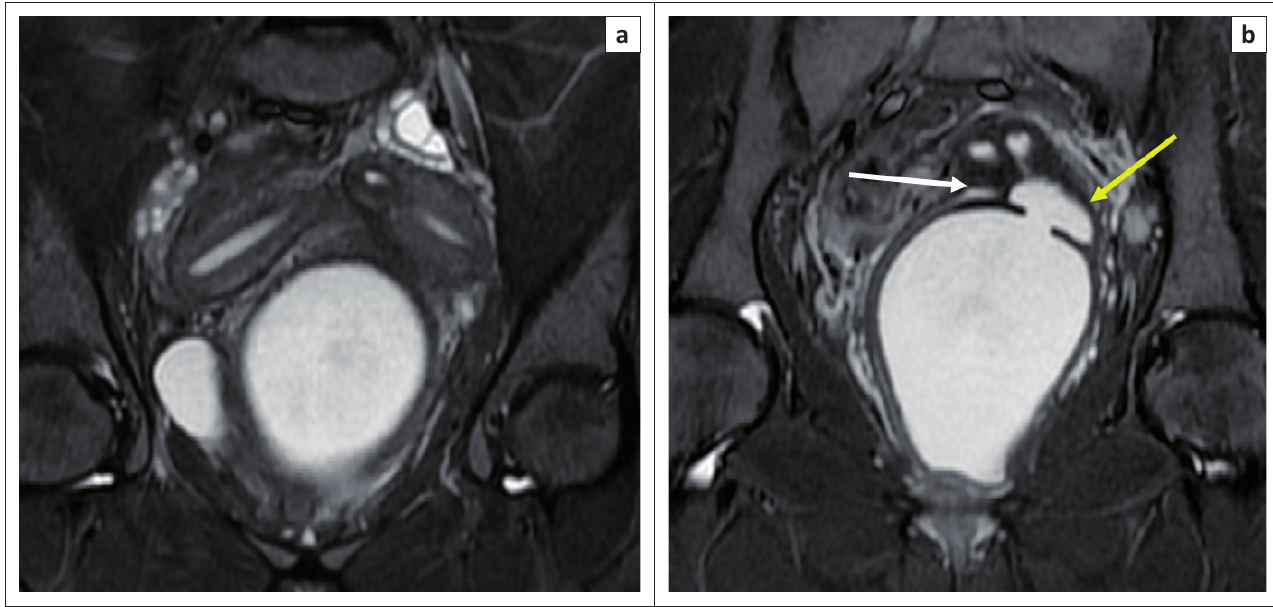
FIGURE 12: Sagittal T2 sequence (a) demonstrates two fundi and two uterine bodies (white arrows) with two endometrial cavities and two cervices (black arrows). Post-partum changes seen in the anterior uterus. (b) Axial T2 sequence shows post-partum changes with the placenta in fundal and left lateral wall (white arrow) – placenta increta.